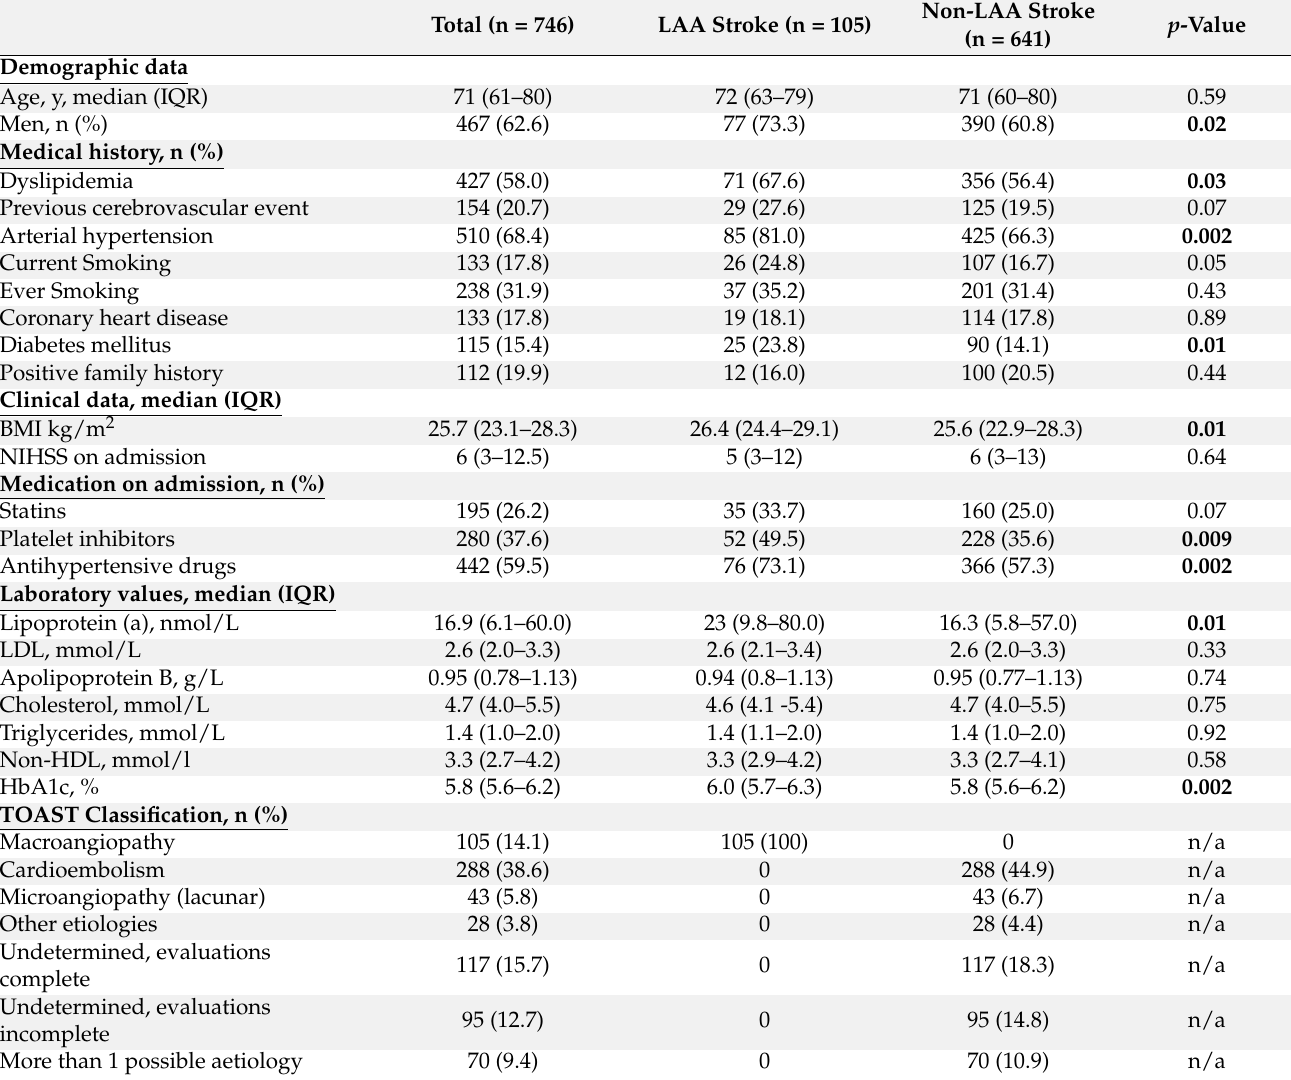
Table 2. Baseline Characteristics of Patients with an acute ischemic stroke. Total (n = 746) LAA Stroke (n = 105)